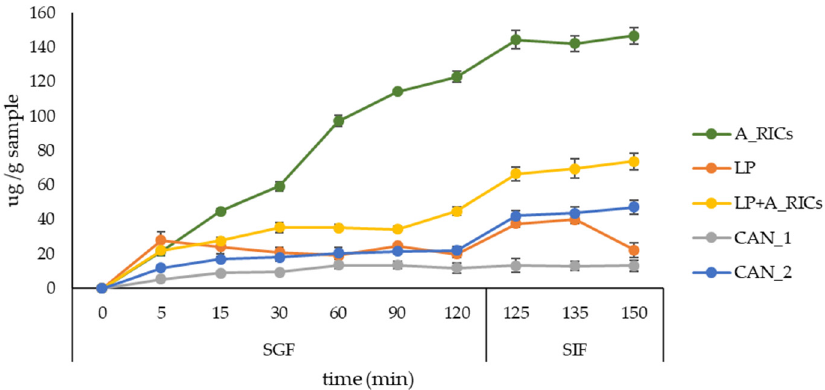
Figure 3. Release of rosmarinic acid in simulated gastro-intestinal digestion from alginate–rice proteins microparticles (A_RICs), loaded liposomes (LP), loaded liposomes coated with alginate–rice proteins gel (LP + A_RICs), candies with incorporated ground ivy extract (CAN_1) and candies with incorporated ground ivy extract and LP + A_RICs (CAN_2).